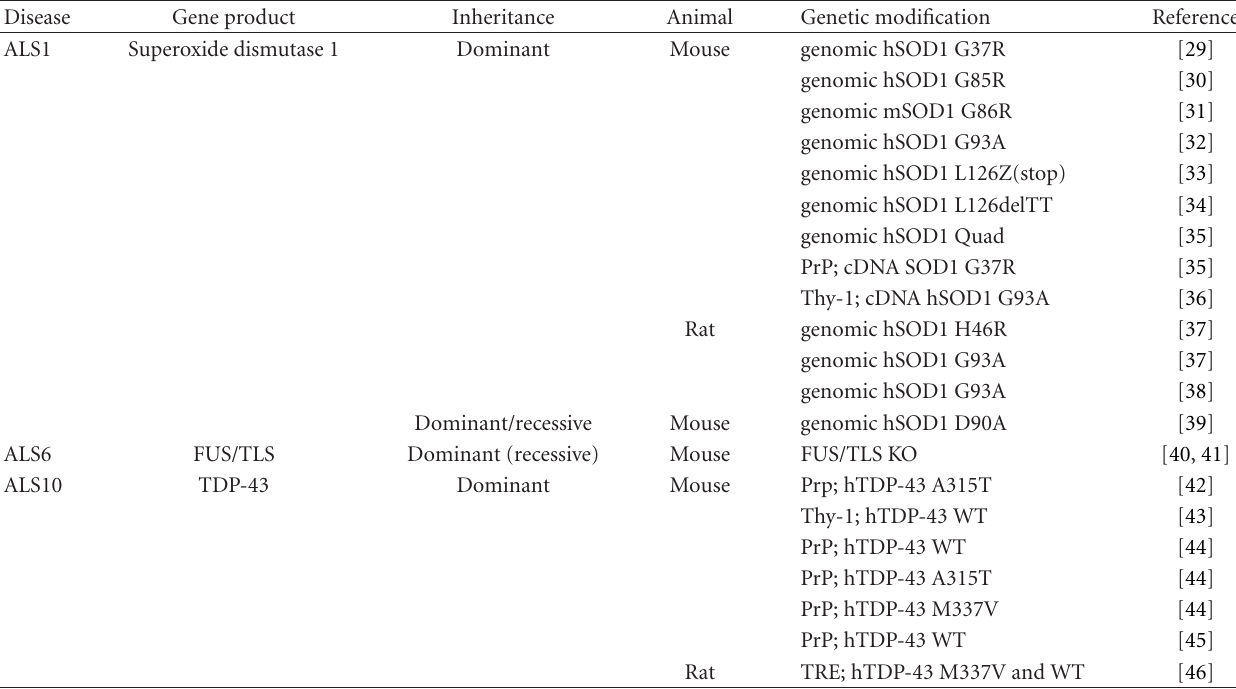
Table 2: Overview of transgenic rodent models for motor neuron degeneration (Mendelian and typical FALS).